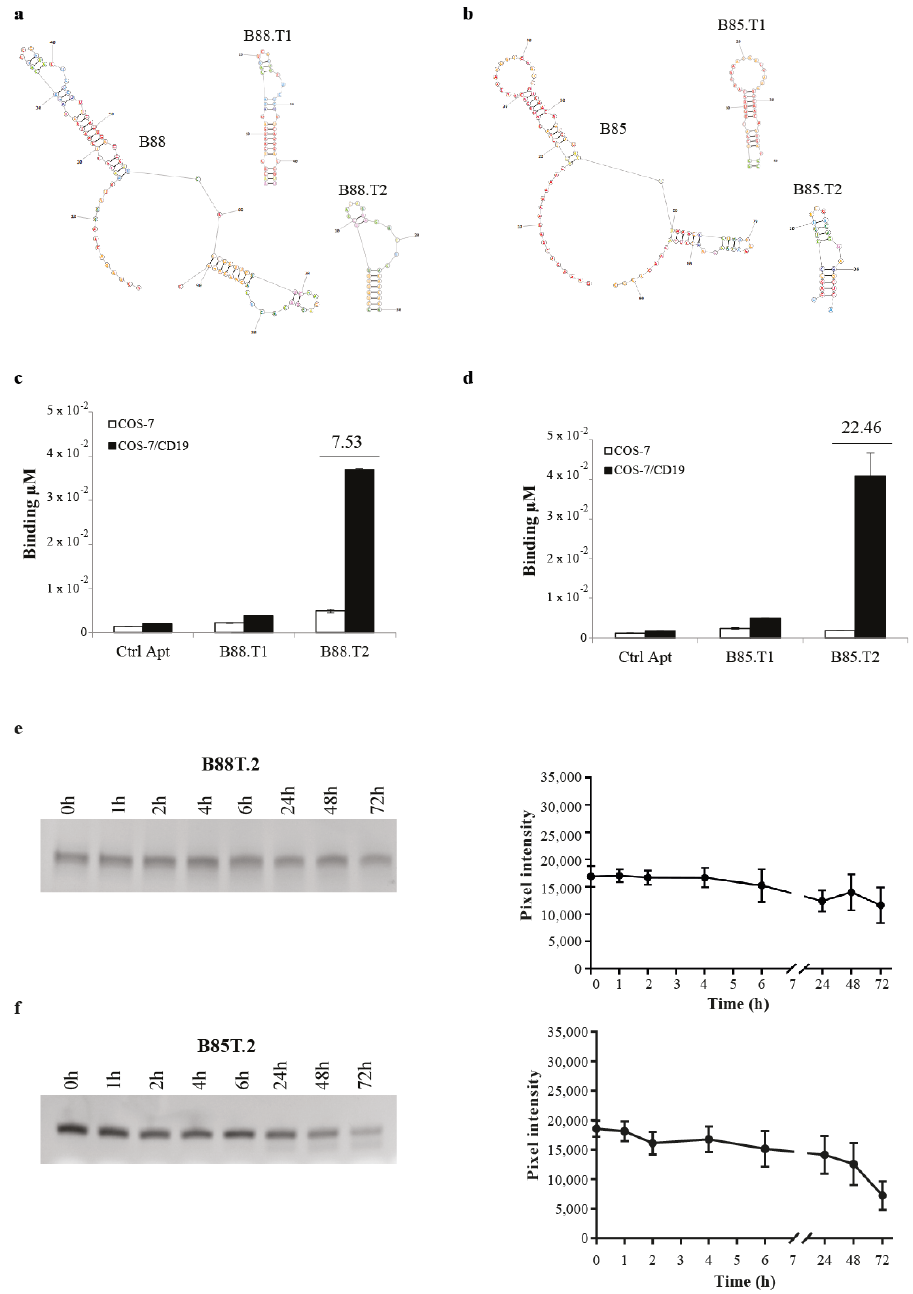
Figure 2. B88- and B85-derived short aptamers. ( a , b ) predicted secondary structures of B88 and B85 aptamers by RNA structure and design of two short versions for each aptamer (B88.T1, B88.T2, B85.T1, and B85.T2. ( c , d ) COS-7 and COS-7/CD19 + cells were treated with 200 nM of indicated aptamers for 30 min at 37 ◦ C. Binding values ( µ M) were measured by qRT-PCR. Error bars show the mean of technical duplicates ± SEM values. ( e , f ) B88.T2 and B85.T2 serum stability. Aptamers (4 µ M) were incubated in 80% human serum for indicated times. At each time point, RNA serum samples were collected and evaluated by electrophoresis on 15% denaturing polyacrylamide gel. Gels were stained with ethidium bromide and visualised at the Gel Doc EZ Imager. Gels representative of three independent experiments are shown (left panels). Original gels are available in Figure S8. Bands were quantified by using ImageJ program, and pixel intensity for each time point is reported in the graphs (right panels). Error bars show the mean of experimental triplicates ± SD values.